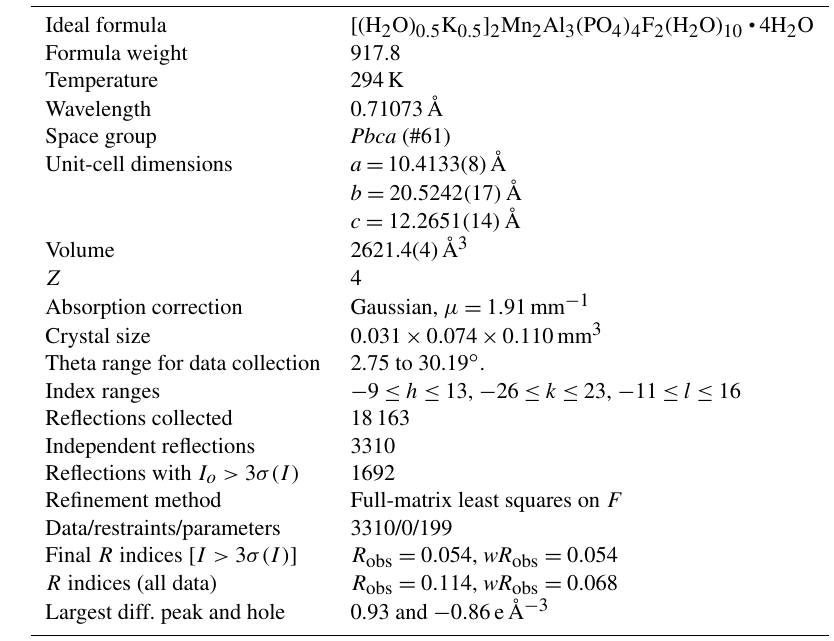
Table 3. Crystal data and structure refinement for pleysteinite.